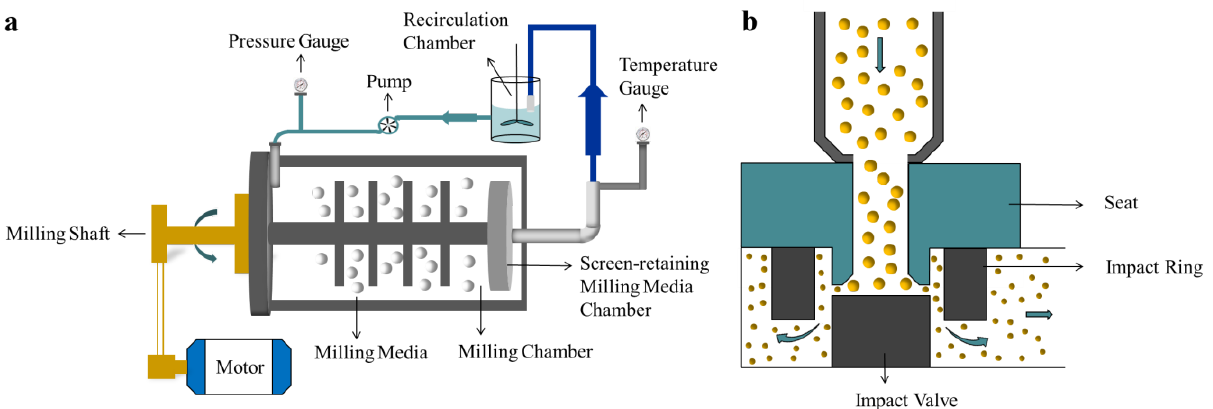
Figure 1. Schematic illustration of the top-down process: ( a ) wet-milling technology; ( b ) high-pressure homogenization technology.